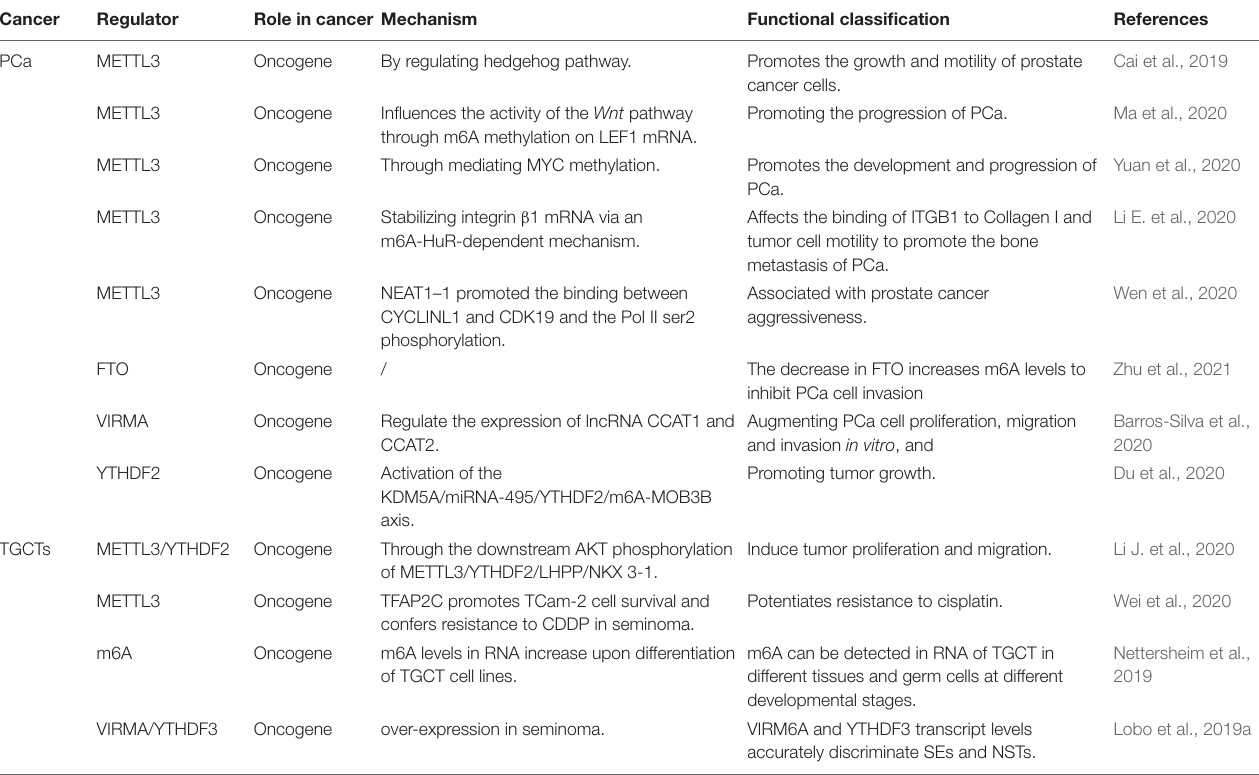
TABLE 2 | Roles of m6A proteins and biological mechanisms exerted in genital system